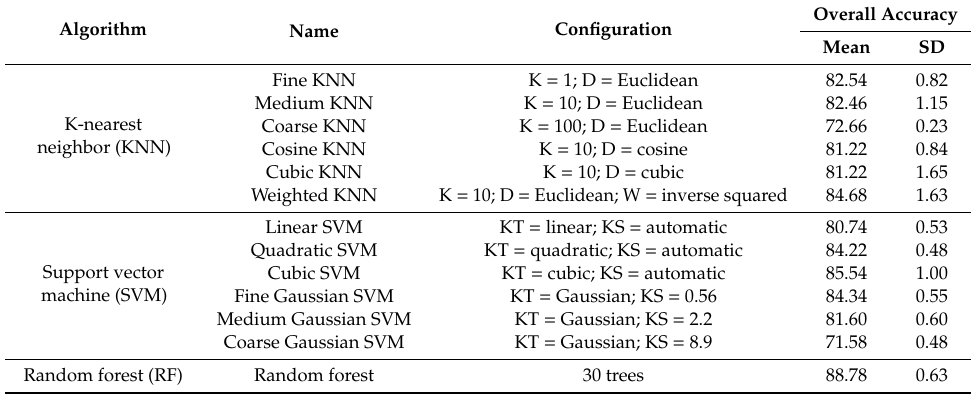
Table A3. Model presets and overall accuracy results using five-fold cross validation by algorithm (i.e., K-nearest neighbor, support vector machine, and random forest models) for the intertidal zone for the contemporary habitat model development for Dauphin Island, Alabama, USA. D: Distance; K = Number of neighbors; KT: Kernel type; KS: Kernel scale; SD: Standard deviation; and W: Weight.